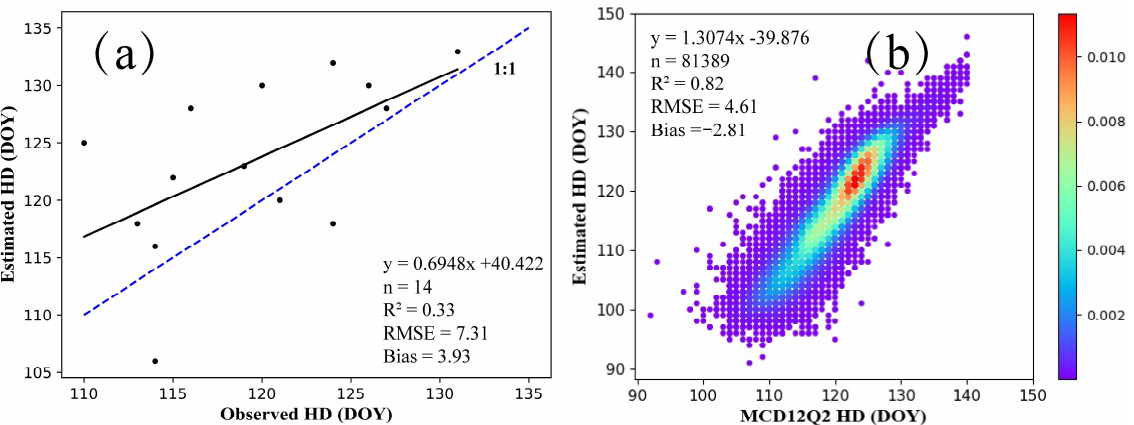
Figure 6. The validation of estimated HD of winter wheat by ( a ) ground observed data and ( b ) MCD12Q2 data.